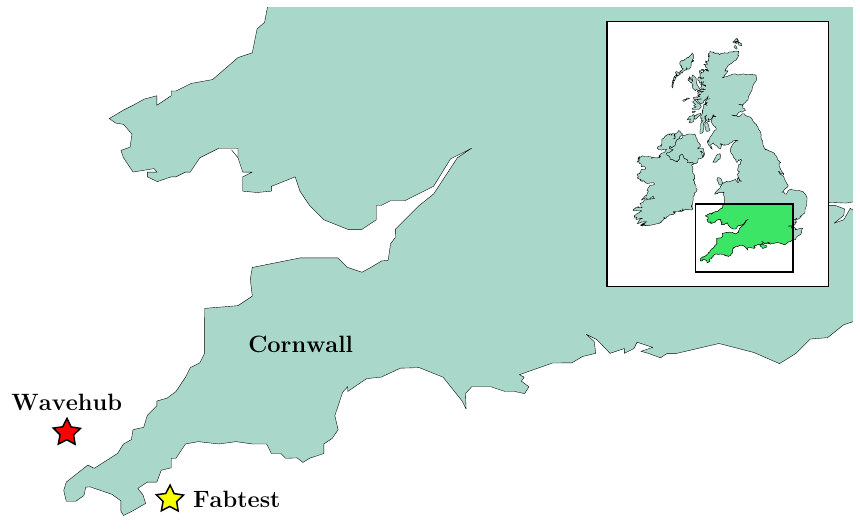
Figure 5. Location of the UK test sites Wavehub and Fabtest